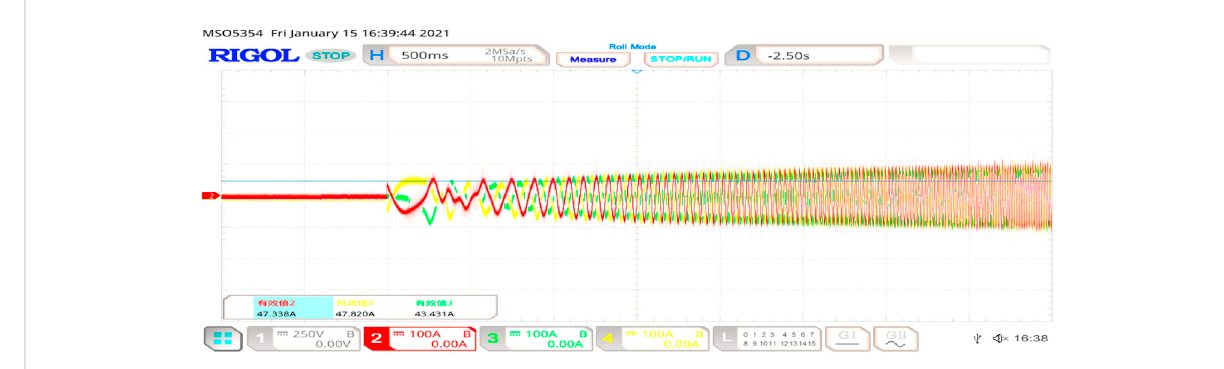
FIGURE 12 Stator three-phase current is from stationary to stable